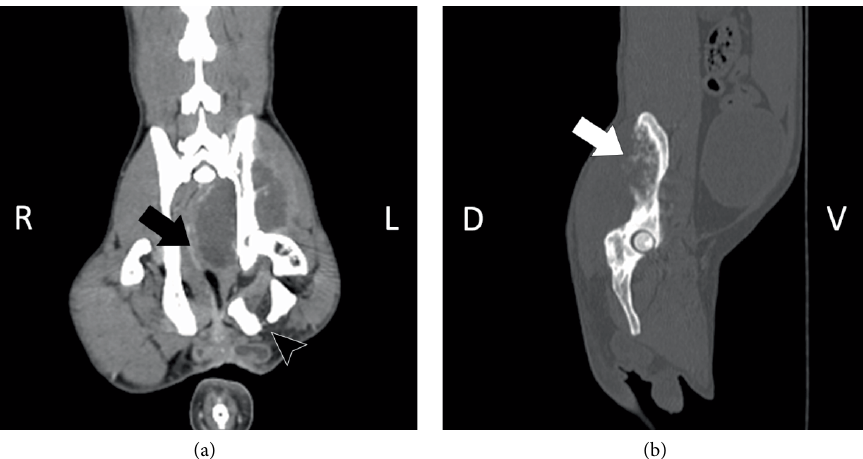
Figure 1: Abdominal computed tomographic images of the cat in bone window dorsal plane post-contrast (a), and sagittal plane (b). A mass can be observed extending into the pelvic cavity with displacement and compression of the rectum to the right (black arrow). Moth-eaten bone less and thin irregular periosteal new bone formation of left ischium is apparent (white arrow). Also note the presence of a chronic left ischium fracture (black